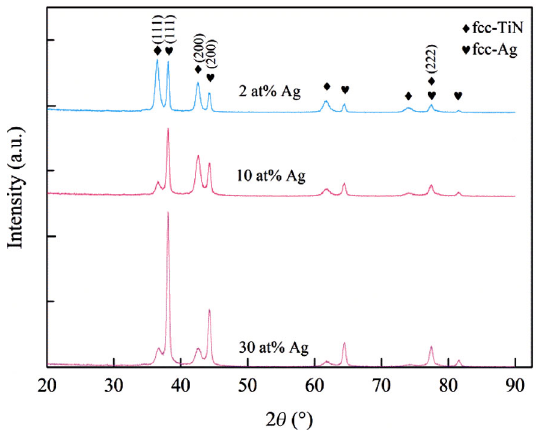
Fig. 4 XRD pattern of coatings with 2 at%, 10 at%, and 30 at% Ag contents.